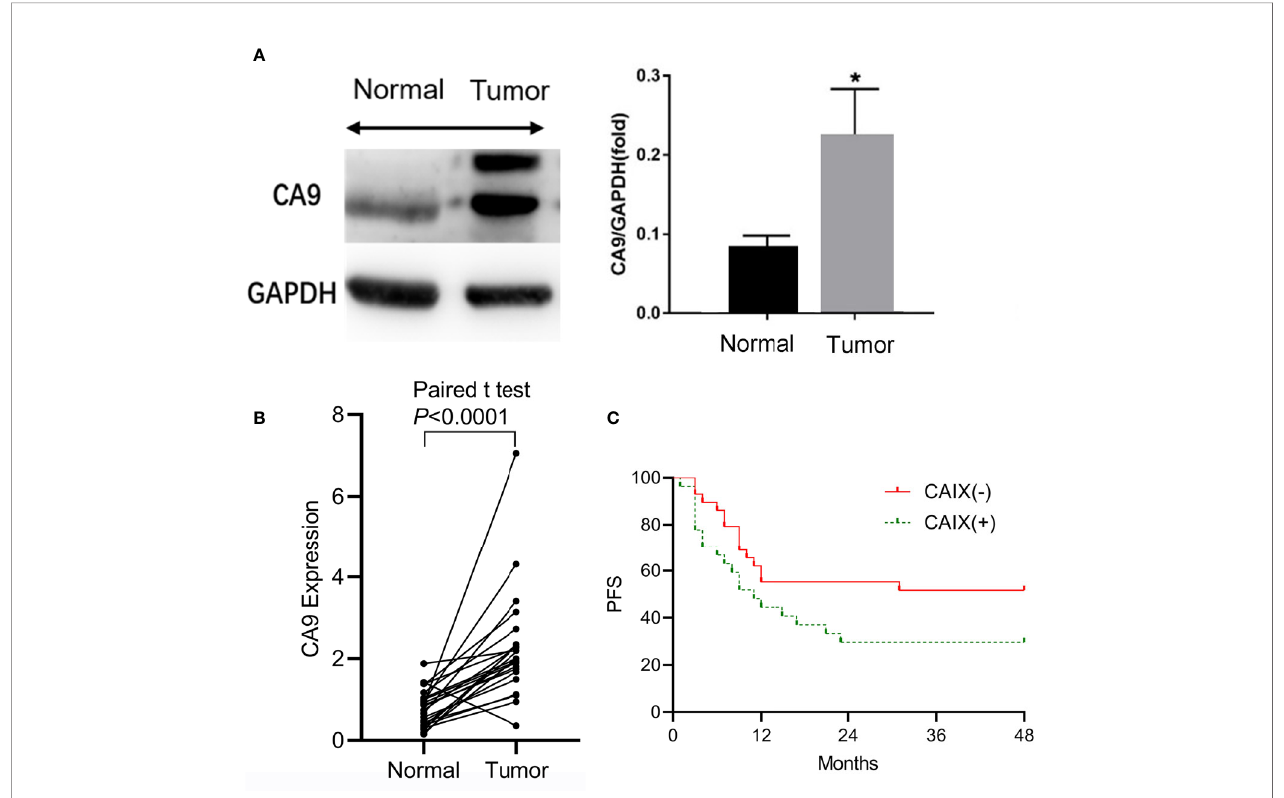
FIGURE 1 | The expression of CAIX in ESCC tissues and its clinical signi fi cance. Twenty-three pairs of ESCC and matched adjacent normal tissue samples were obtained for analysis. (A) The protein and mRNA expression levels of CAIX were measured by Western blot and qRT-PCR, respectively. (B) ESCC tissue samples were stained for CAIX using immunohistochemistry method. (C) The Kaplan-Meier survival analysis of ESCC patients with positive (n=27) or negative (n=29) expression of CAIX. * P <